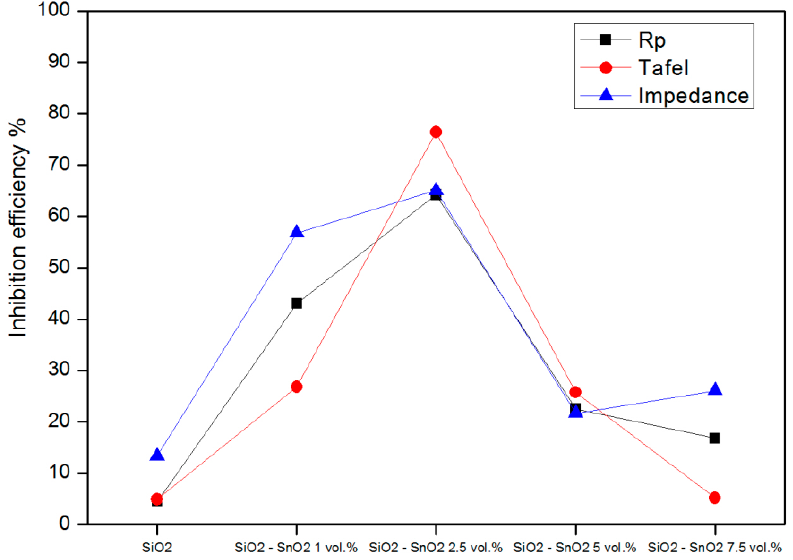
Table 4. The corrosion parameters obtained from